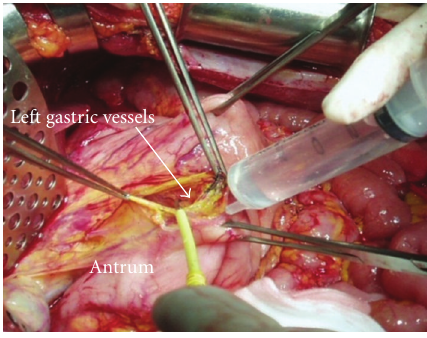
Figure 3: A 5% dextrose solution is injected in the incision site on the lesser curvature, and the left gastric vessels are identified and taped. Aqua dissection technique.